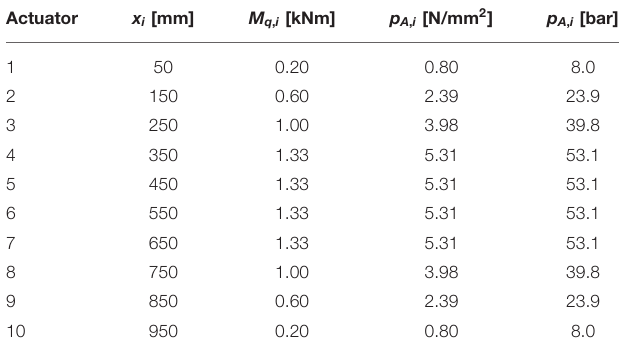
TABLE 1 | Calculated hydraulic pressure in each